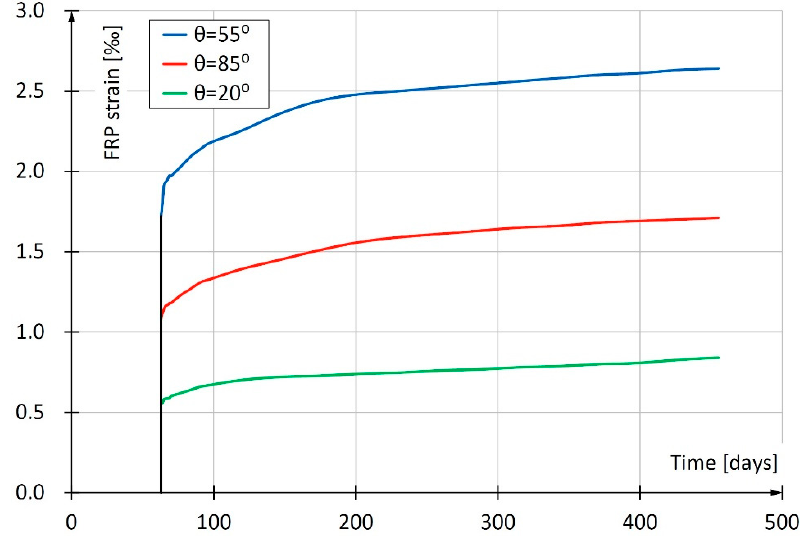
Figure 18. Creep curves at axial compression (t 0 = 63 d) at stress σ = 0.46 · f c (28).